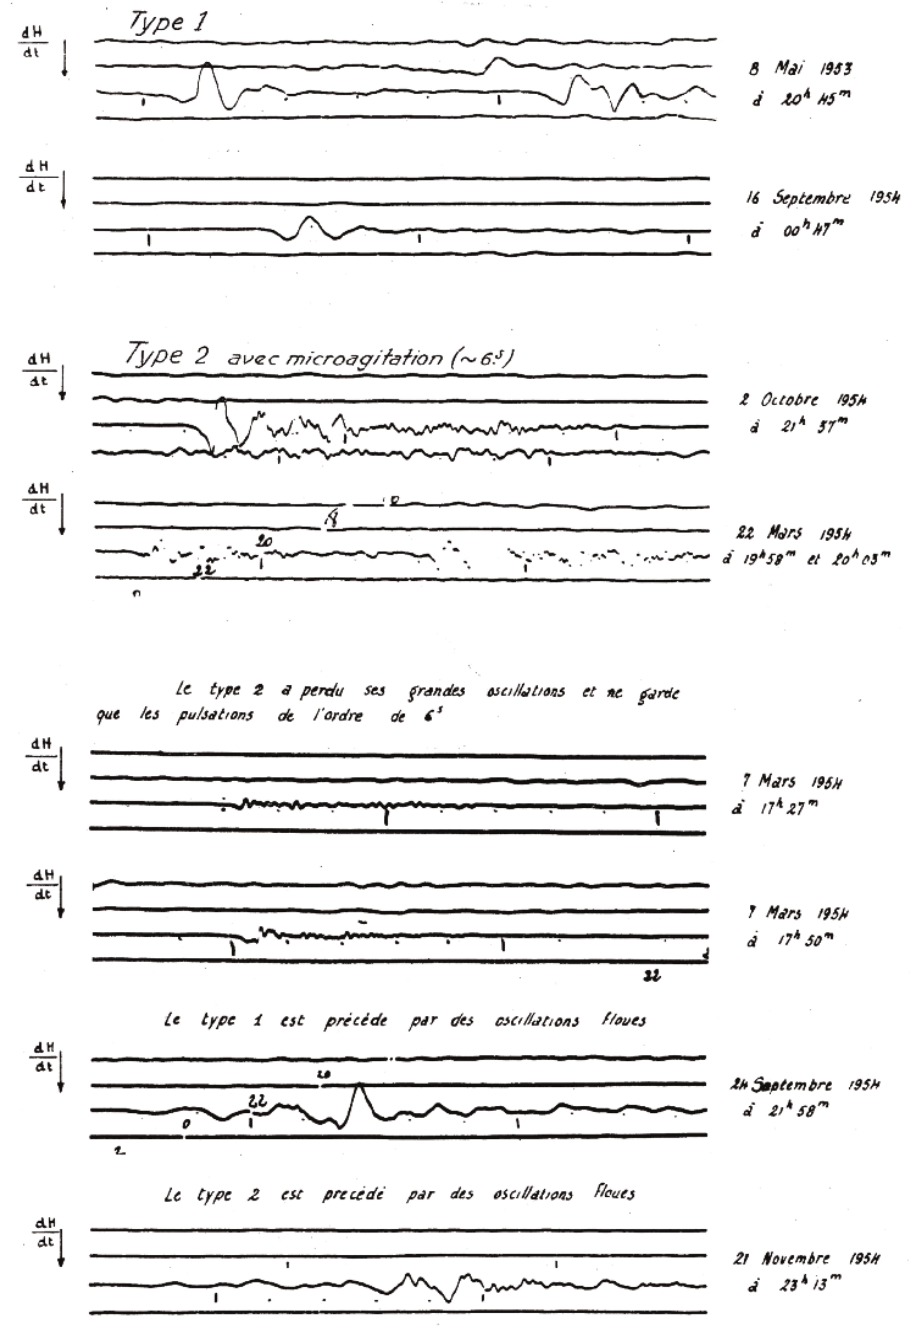
Figure 9. Types de pt (d’après